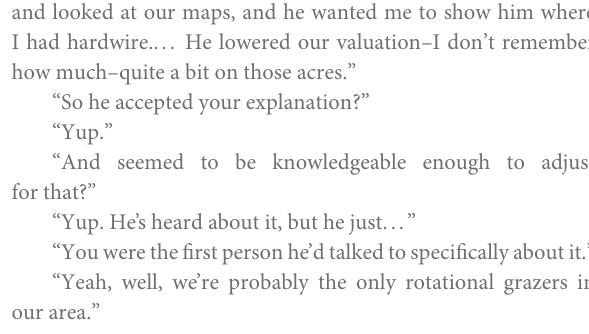
Figure 4 groups search term appearances from 2009 to 2013 and